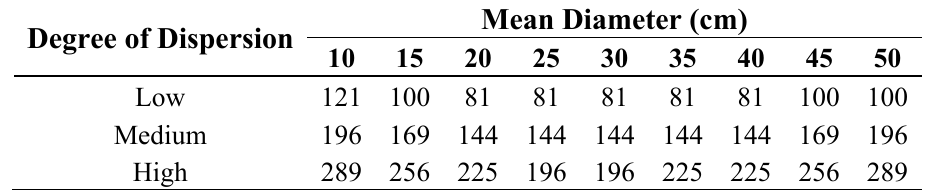
Table 5. Number of sampling points for accuracy of Δ% = 5% at the 95% confidence